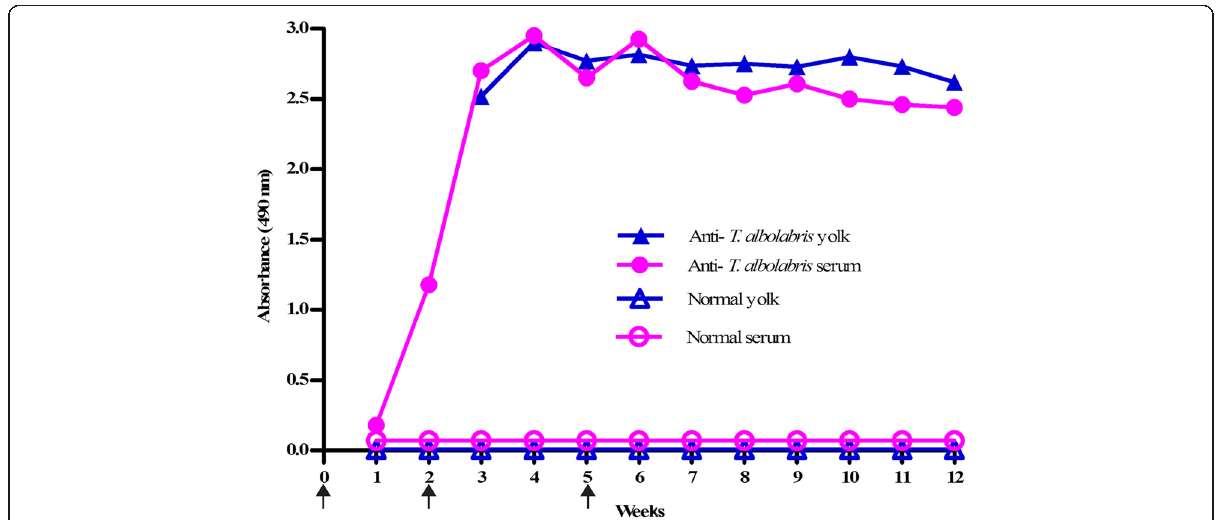
Fig. 1 Primary and secondary antibody response in serum and egg yolk of chickens immunized with T. albolabris venom. Anti- T. albolabris (WSF, water- soluble fraction) activity was determined by ELISA (as described in Materials and Methods section). Arrows indicate